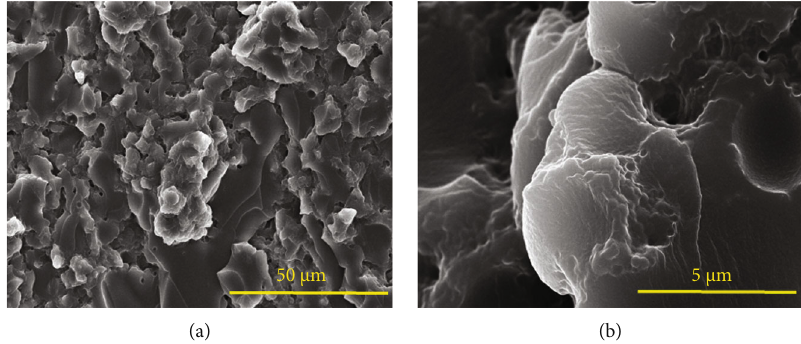
Figure 7: Scanning electron micrographs of (a) 50 µm and (b) 5 µm of E/C/M (3.1K, 5phr)